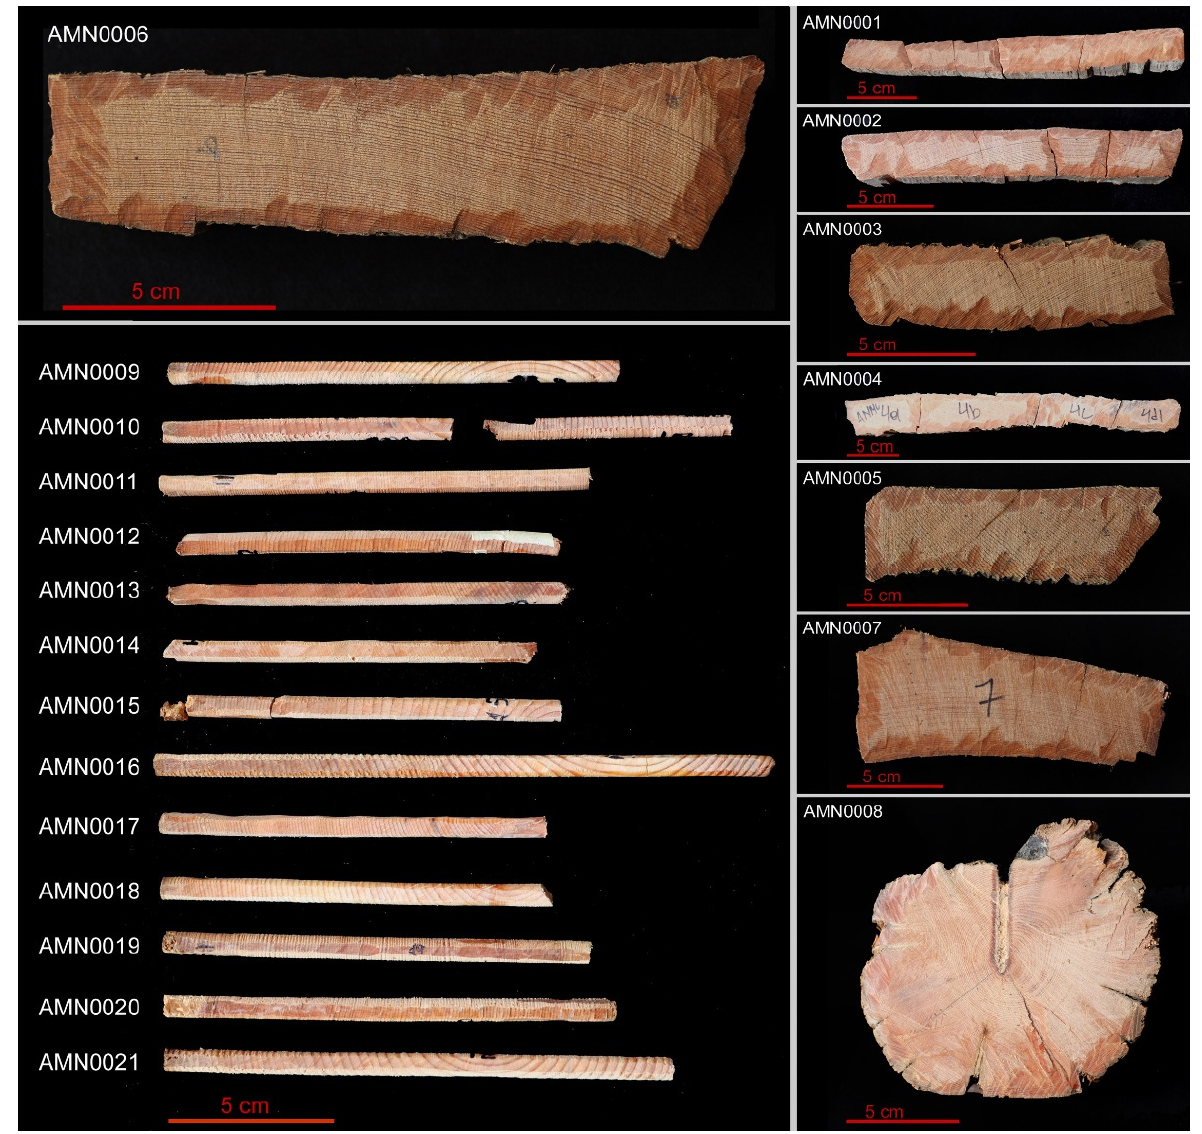
Figure 4. Samples collected in the Monastery’s auxiliary building.